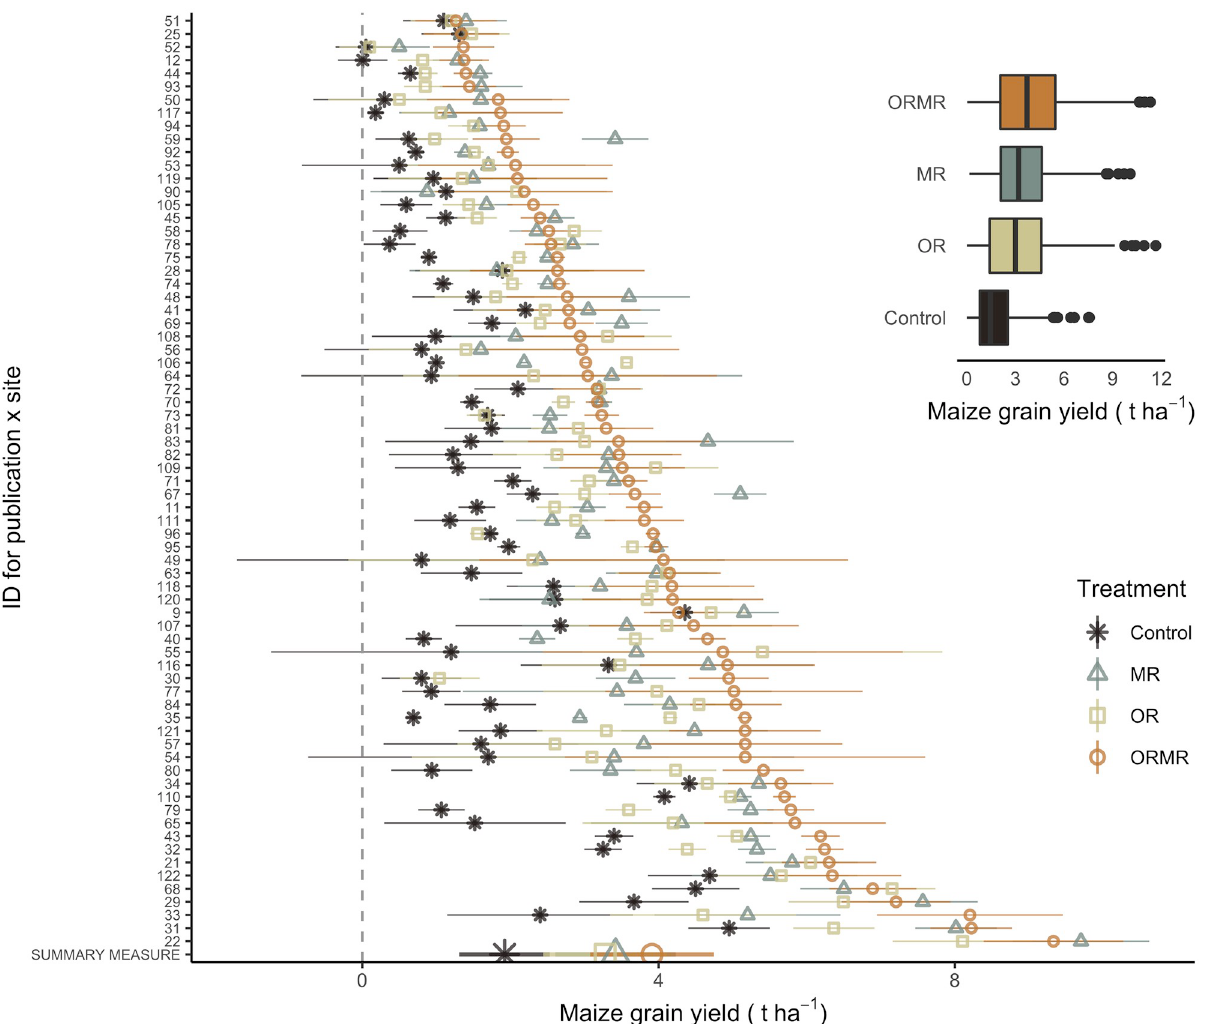
Fig 4. (left) Overview of reported maize grain yield (t ha -1 ) data, averaged by publication, site, and treatment, and ranked following increasing ORMR yields. Error bars represent the +- 1.96 � mean standard error on that average. The overall yield average by treatment and across publications and sites is labeled as ‘summary measure’ at the bottom of the graph. (top right) Distribution of maize grain yield (t ha -1 ) values by treatment.